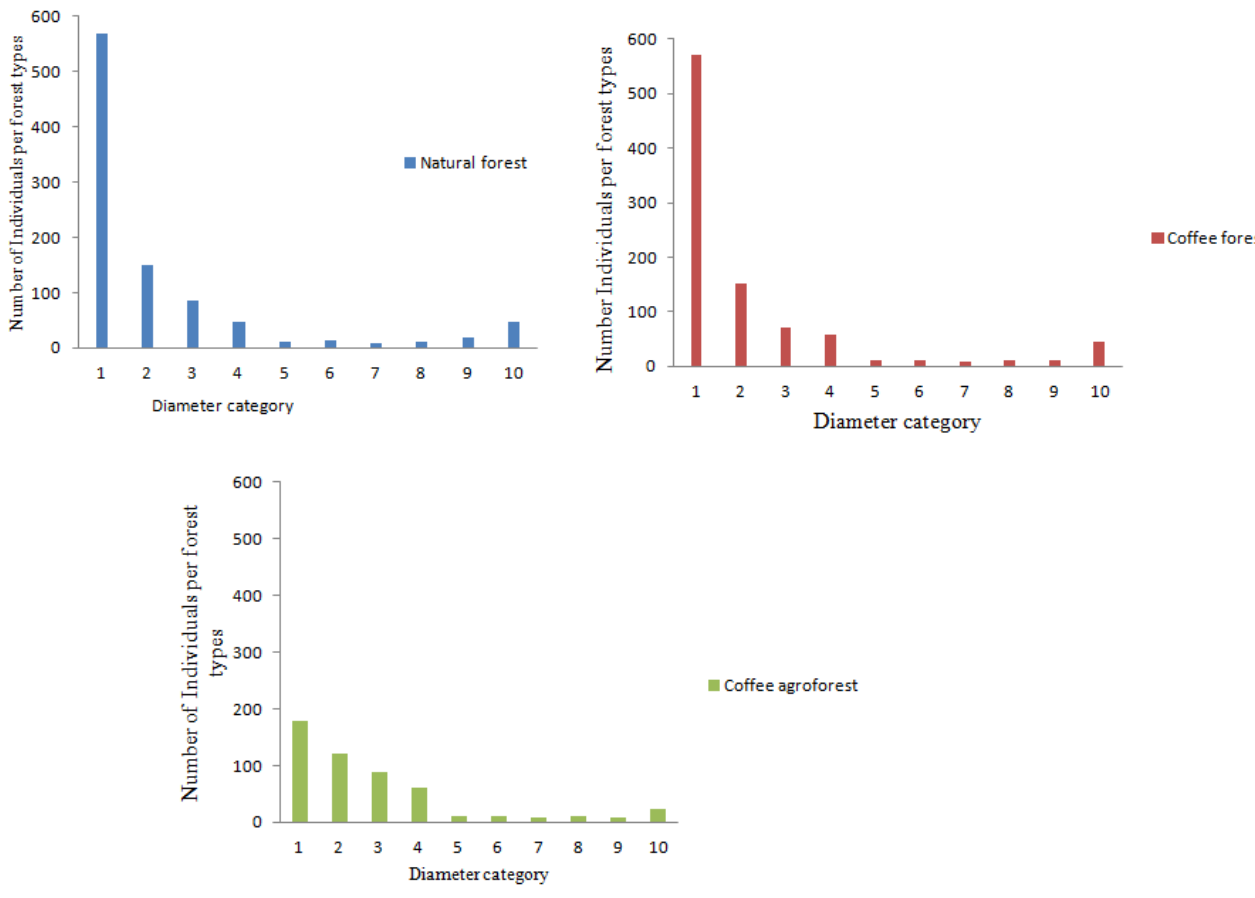
Natural For- Coffee Ag- Coffee Forest p -Value est roforest